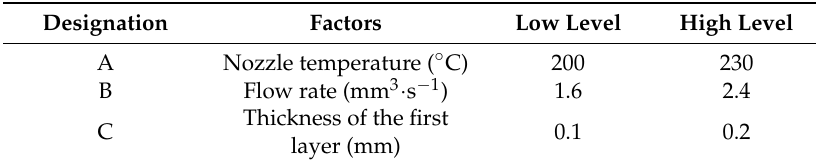
Table 1. The investigated factors and their corresponding designation and low and high level of the design of experiments